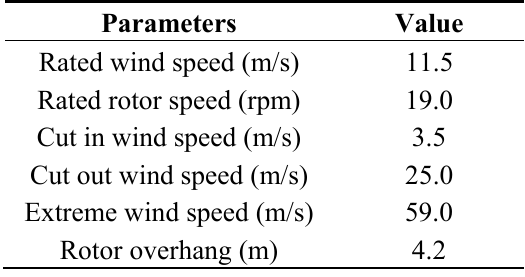
Table 1. Specifications of the 1.5 MW wind turbine blade.